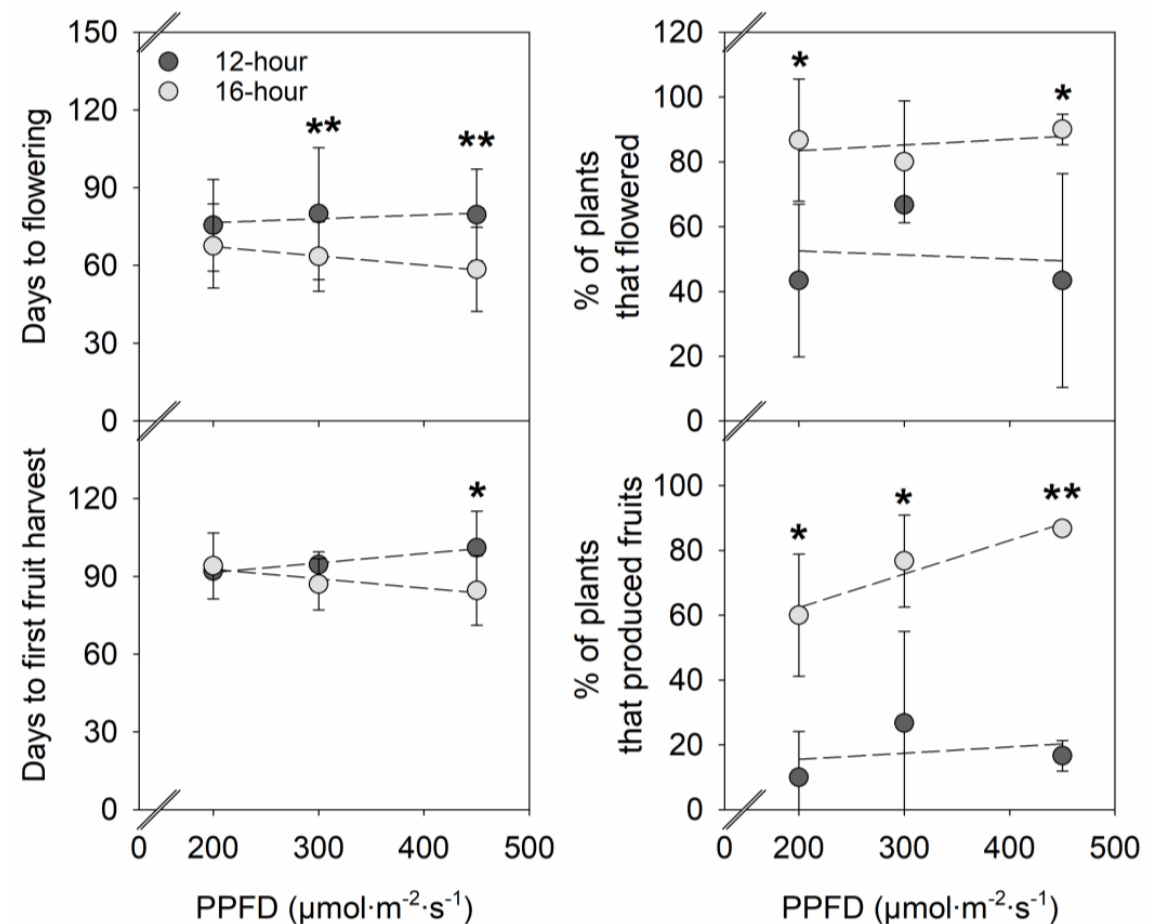
Figure 4. Influences of photosynthetic photon flux density (PPFD) and photoperiod of sole-source lighting treatments on days to first flower, days to first fruit harvest, percentage of plants that flowered, and percentage of plants that produced fruits of strawberry ‘Albion’. Each data point represents the mean and standard deviation of two replications (n = 2). At each photoperiod, linear relationship with PPFD is indicated with dashed line when insignificant ( p ≥ 0.05). At any PPFD, * or ** indicates a significant difference at p < 0.05 or 0.01 at a 12-h or 16-h photoperiod, respectively. There were no significant effects of PPFD and photoperiod on the fresh mass and diam- eter of individual fruit (Figure 5). PPFD also did not influence the total fruit production and total number of fruits. However, at each PPFD, the total number of fruits was